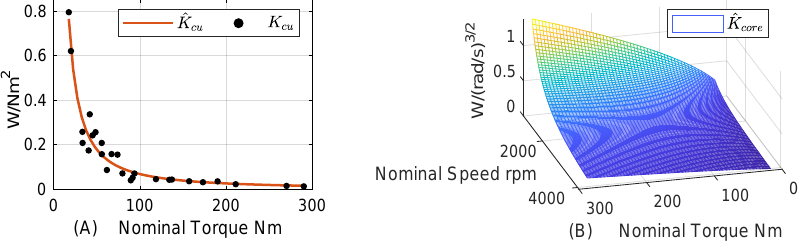
Figure 7. ( A ) Water cooled MS2N copper loss coefficient; ( B ) water cooled MS2N core loss coefficient with ε c = 1.